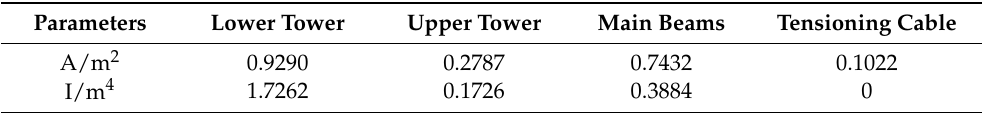
Table 2. Basic calculation